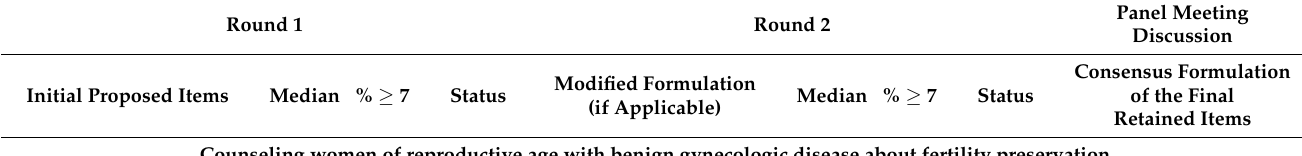
Table A1. Set of initial and final statements used in the Delphi process to define indications for fertility preservation in women with benign gynecologic disease, with a description of the selection process through the approval of the final clinical